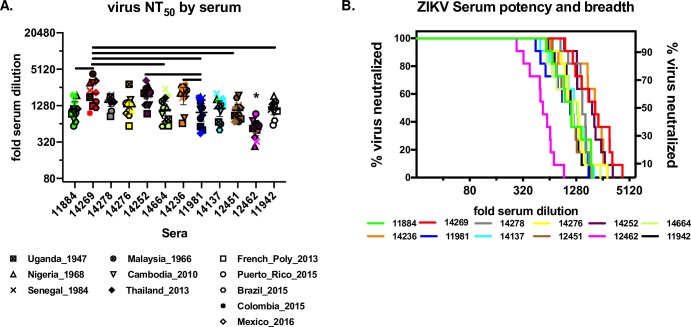
Potency and breadth of subject immune sera.A) GMT for each serum against eleven ZIKV isolates. Y-axis shows fold-serum dilution, each virus FNRT50 value is plotted by the correlating symbol show in the legend below the plot. The symbols are color coded to match the sera indicated in Fig 2. Line and whiskers show serum GMT and 95% confidence. The GMT for subject 12462 (*) was significantly lower than all other sera (ANOVA followed by Tukey’s correction for multiple comparisons, P<0.05). Remaining sera pairs that had GMTs that differed significantly are show by horizontal bars (ANOVA followed by Tukey’s correction for multiple comparisons, P<0.05) B) Potency and breadth curve for each subject serum. The Y-axes shows proportion of viruses neutralized (N = 11), X axis shows fold serum dilution. The plots are color coded to match the sera in Fig 2. The plot for each serum shows the proportion of viruses neutralized by FRNT50 at a given serum dilution. Each step in each plot represents an FRNT50 value for one virus; as fold serum dilution increases for each serum, the proportion of viruses neutralized decreases by 1/11 (9.1%) as each FRNT50 dilution for each virus is crossed. *differs from 12462, Mantel-Cox followed by Bonferroni’s correction for multiple comparisons, P<0.05.